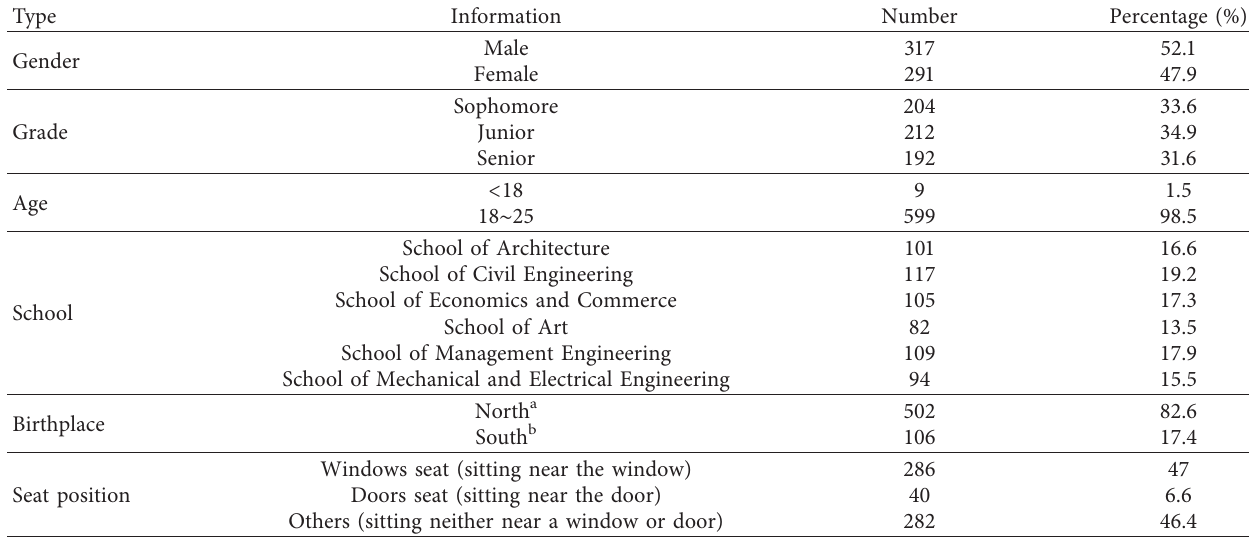
Table 3: The basic information of respondents.